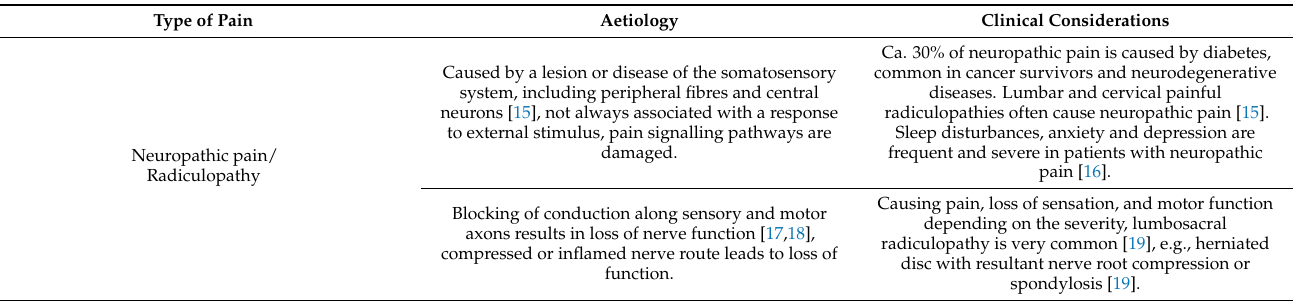
Table 1. Types of chronic pain, aetiology and clinical